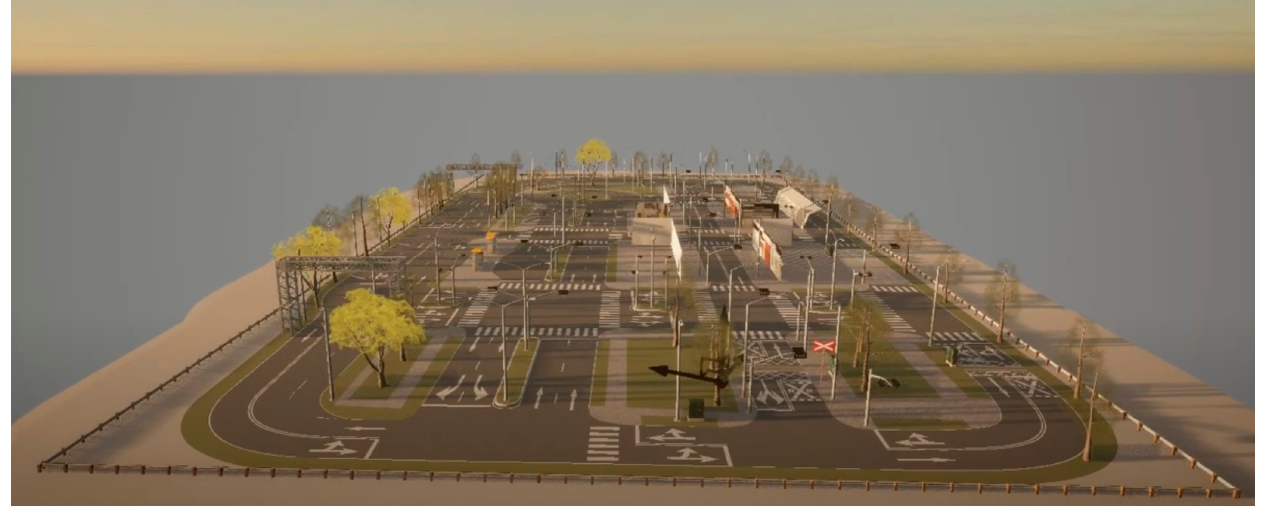
Figure 12. OpenDRIVE scene in the CARLA simulator.